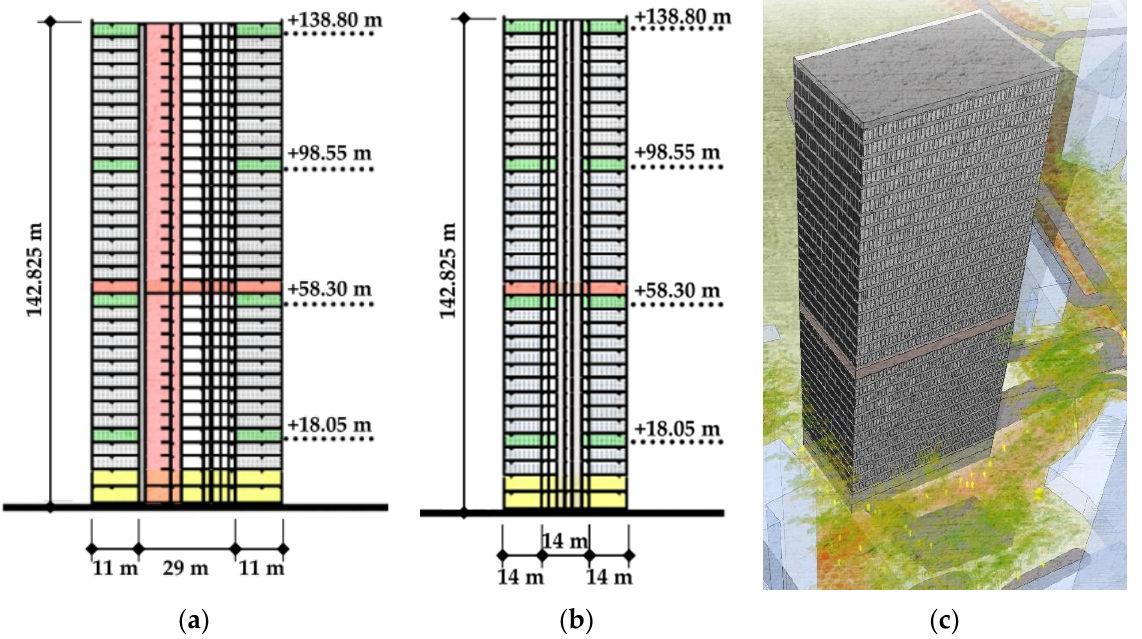
Figure 1. ( a ) Elevation (long section), ( b ) elevation (short section) and ( c ) bird-eye view of the observed building.